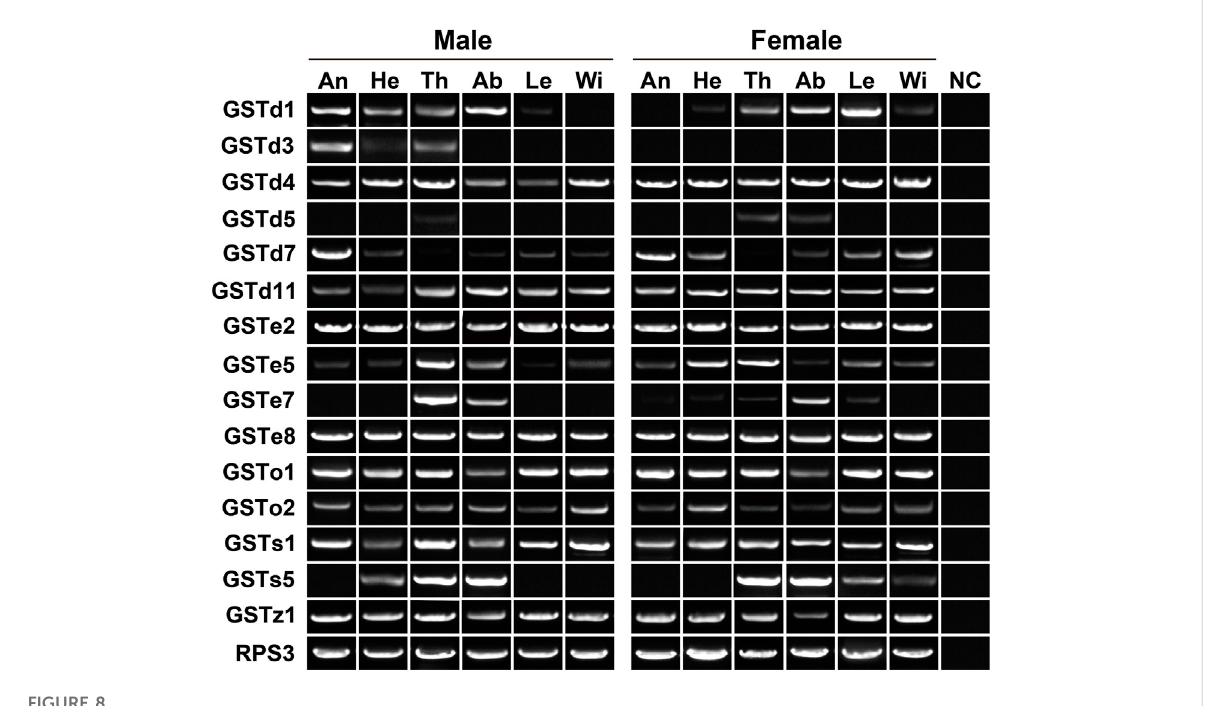
FIGURE 8 Expression patterns of 15 GST genes in various tissues of P. antennata . The abbreviation of tissues is seen in Table 1. NC, negative control using sterile water as the